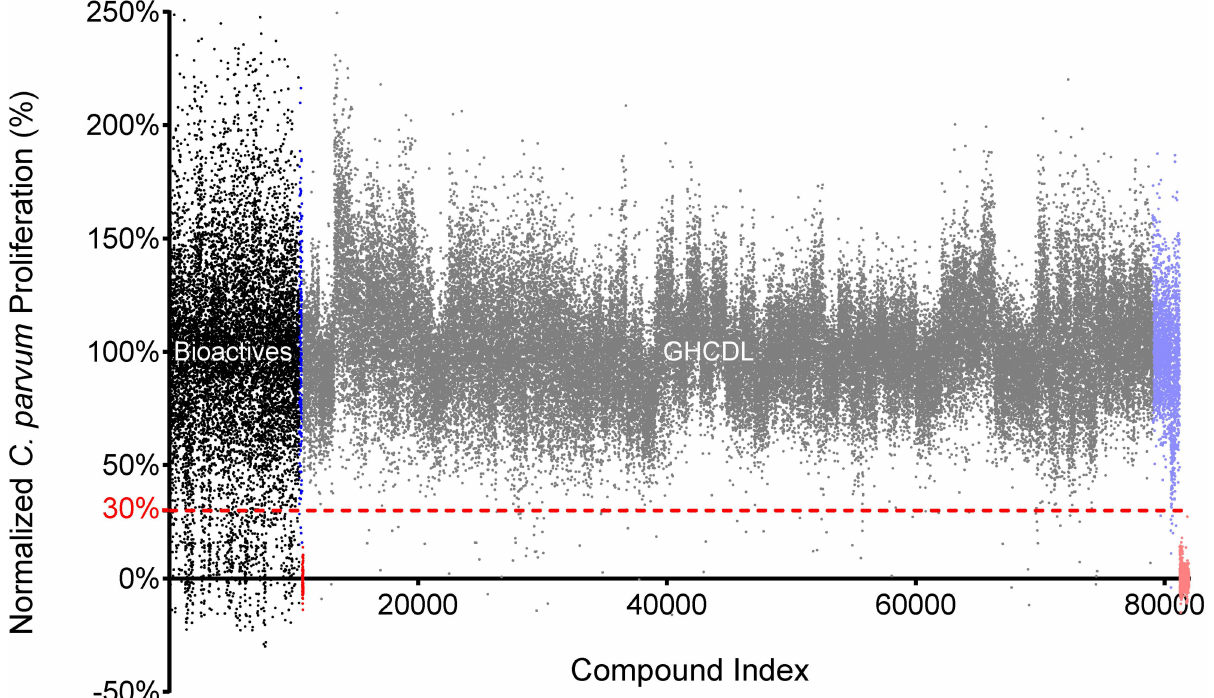
Fig 2. High-throughput screening results of 78,942 compounds shows inherent variability. Scatter plot of normalizedactivity all compoundsscreenedat 1.88 μ M (Black = Bioactives; Gray = GHCDL). A strict cut-off of 70% inhibitionof C . parvum proliferation (dotted red line) was appliedto yield 812 primary hits. Neutralcontrols (0.125%DMSO; Blue = Bioactives; Lavender = GHCDL) and inhibitorcontrols (0.5 μ M FDU; Red = Bioactives; Light red = GHCDL) are also shown to demonstrate the inherentvariability in the assay.